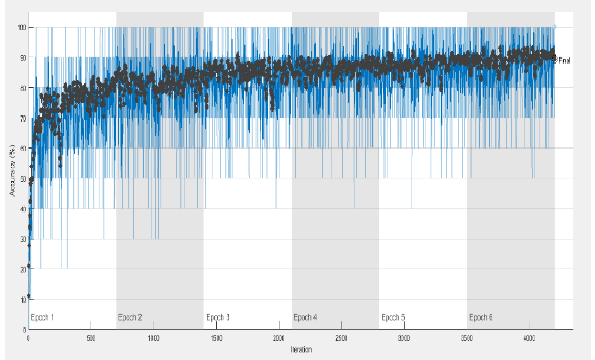
Figure 5. Accuracy plot at each iteration of VGGNet